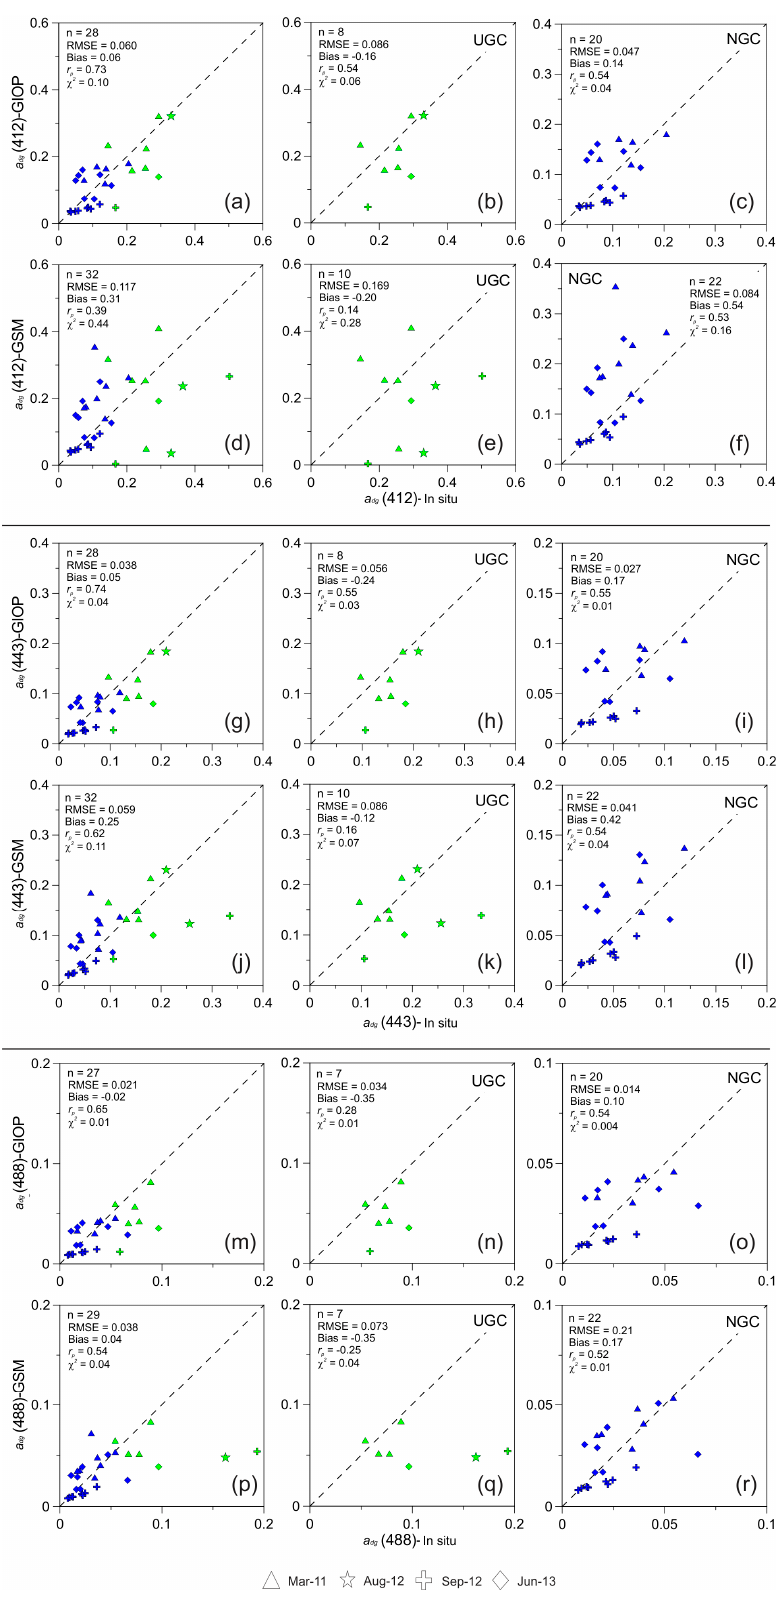
Figure 7. Comparative analysis between in situ and satellite a dg (412, 443, and 448) for the GIOP and GSM algorithms, with statistics Root Mean Square Error (RMSE), bias, r p , and χ 2 . The 1:1 is indicated for reference. The green and blue colors correspond to the UGC and NGC regions, respectively. In the first column ( a , d , g , j , m , p ) the entire database was used, in the second ( b , e , h , k , n , q ) only data from UGC, and in the third ( c , f , i , l , o , r ) only data from